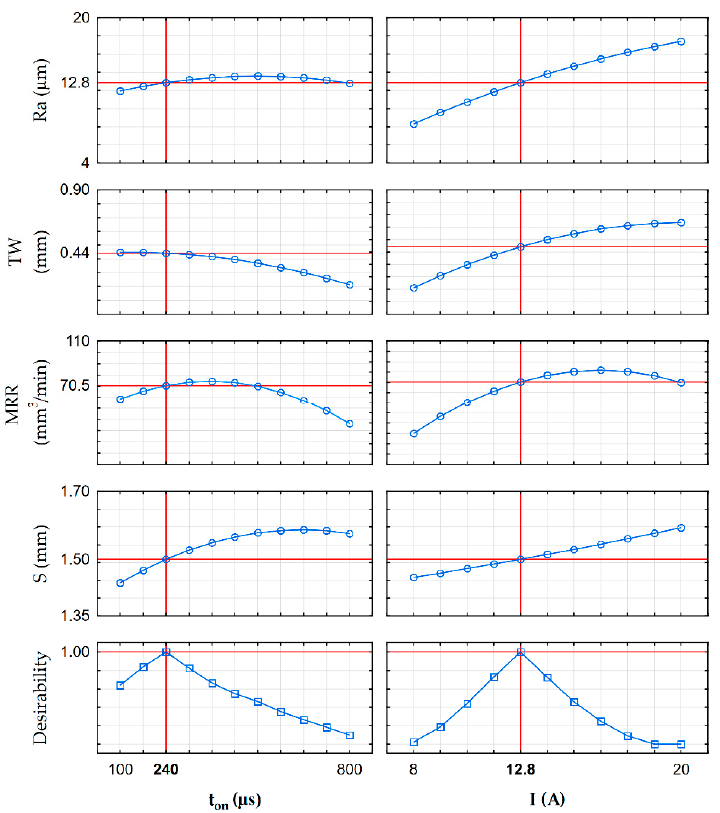
Figure 17. Profiles for predicted values and desirability for adopted criteria of EDM optimization. Table 11. Experimental validation of the values obtained from multi-response